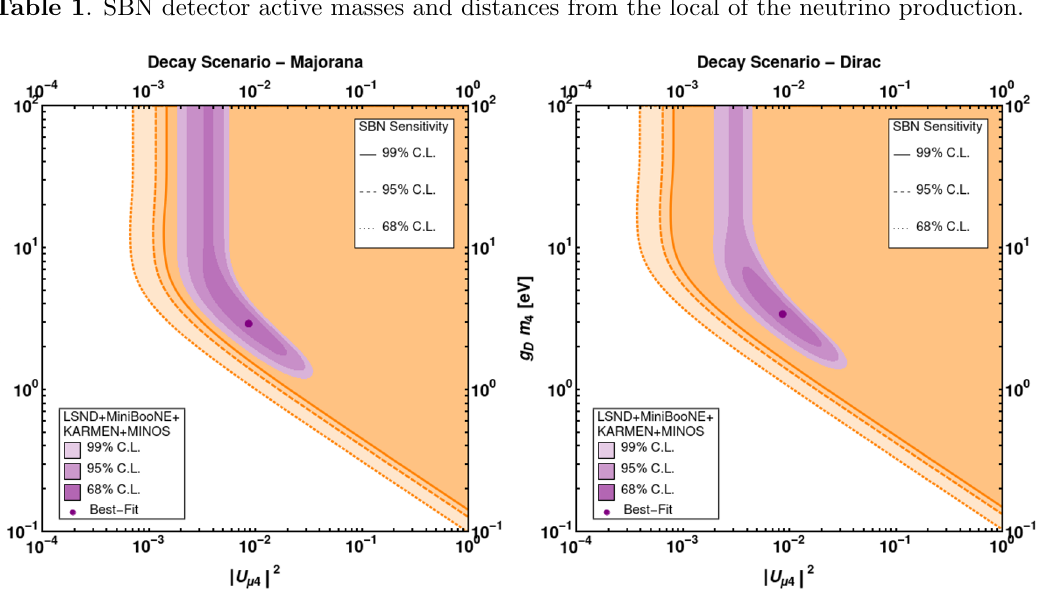
Figure 8 . Allowed regions at 99% (lighter purple), 95% (medium purple) and 68% (darker purple) C.L. of the ( j U (cid:22) 4 j 2 ; gm 4 ) parameter space when the decaying-sterile-neutrino hypothesis is matched against the combined LSND, MiniBooNE and KARMEN data and MINOS constrains assuming Majorana (left) or Dirac neutrinos (right). The dots indicate the best-(cid:12)t-point. In the same context, the orange regions indicate the sensitivity of the SBN Program at 99% (solid line), 95% (dashed line) and 68% (dotted line) C.L. for Majorana (left) and Dirac neutrinos (right). We